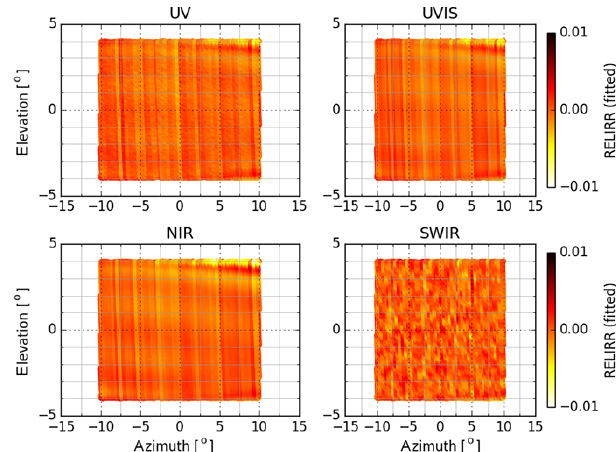
Figure 8. The relative irradiance (RELIRR) in-flight measurements for diffuser 1 (QVD1) divided by their reference measurements. Shown are the values for the different solar angles for a super pixel in the detector corner (row 20, column 30) for each detector. The variation in azimuth direction is smooth. For both solar angles the signal cut-off is visible.